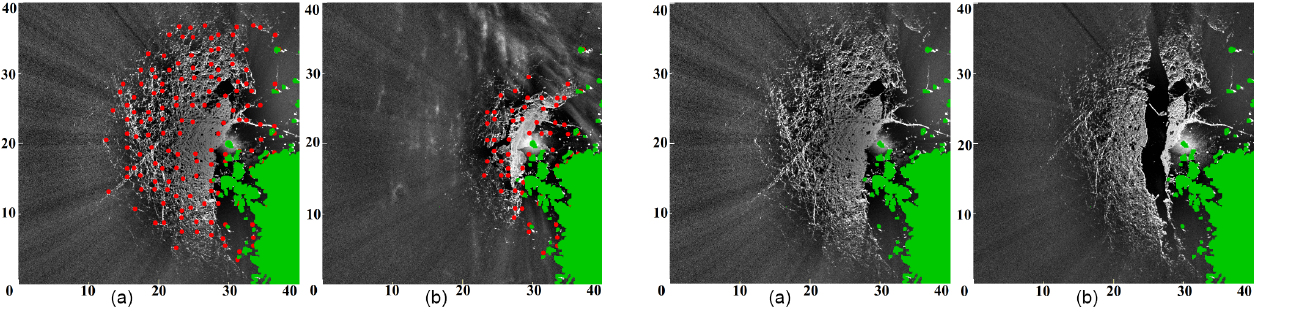
Figure 7. The first and last image of the February 2011 test data set. The coordinates are in kilometres, and the radar is located at (row, column) = ( 20 , 30 ) . The land area according to our rough land mask is indicated in green. The associated scale is in kilometres.